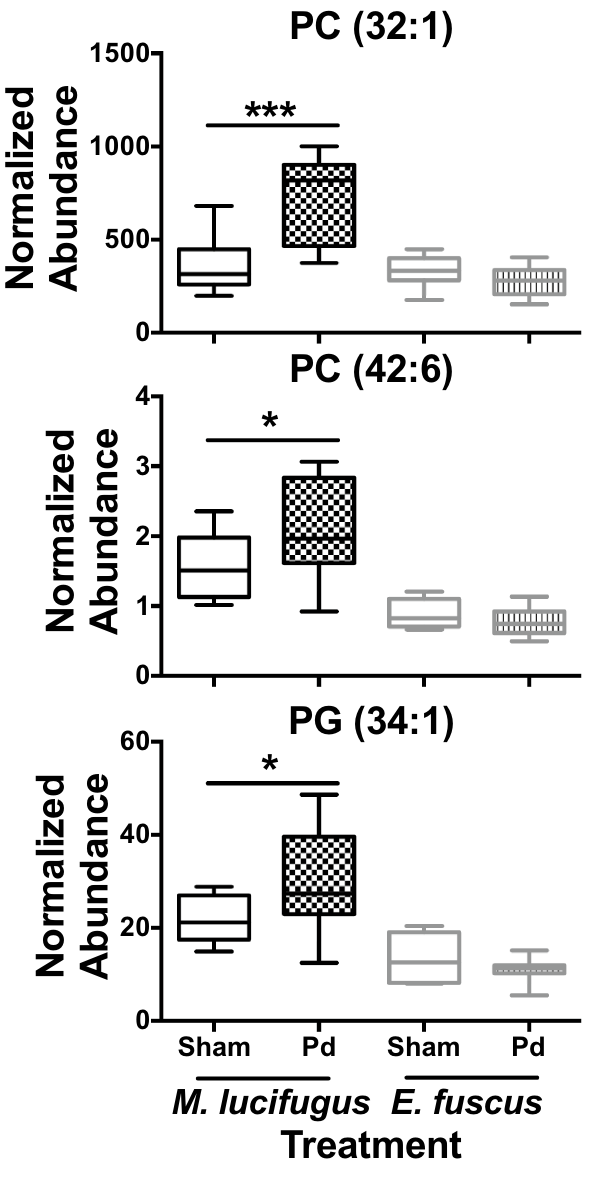
Figure 5. Box and whisker plots of hepatic phosphatidylcholine (PC) and phosphatidylglycerol (PG) found at higher concentrations in Myotis lucifugus after Pseudogymnoascus destructans (Pd) infection. Relative levels found in Eptesicus fuscus are shown as a comparison. * P ≤ 0.05; *** P ≤ 0.001 determined by an unpaired t test, lines from top to bottom represent max value, 75th percentile, median, 25th percentile, min value, E. fuscus n = 8 for both groups, M. lucifugus sham-inoculated n = 12, Pd-inoculated n =